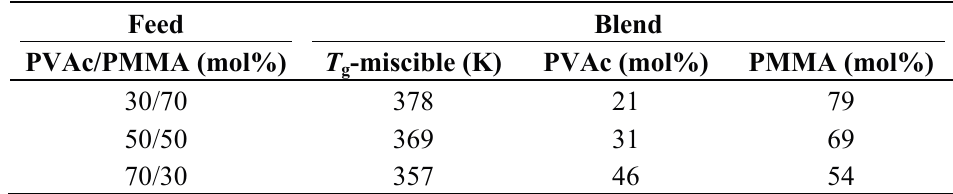
s of PMMA/PVAc blends coalesced from their stoichiometric U-ICs Table 3. T g-miscible